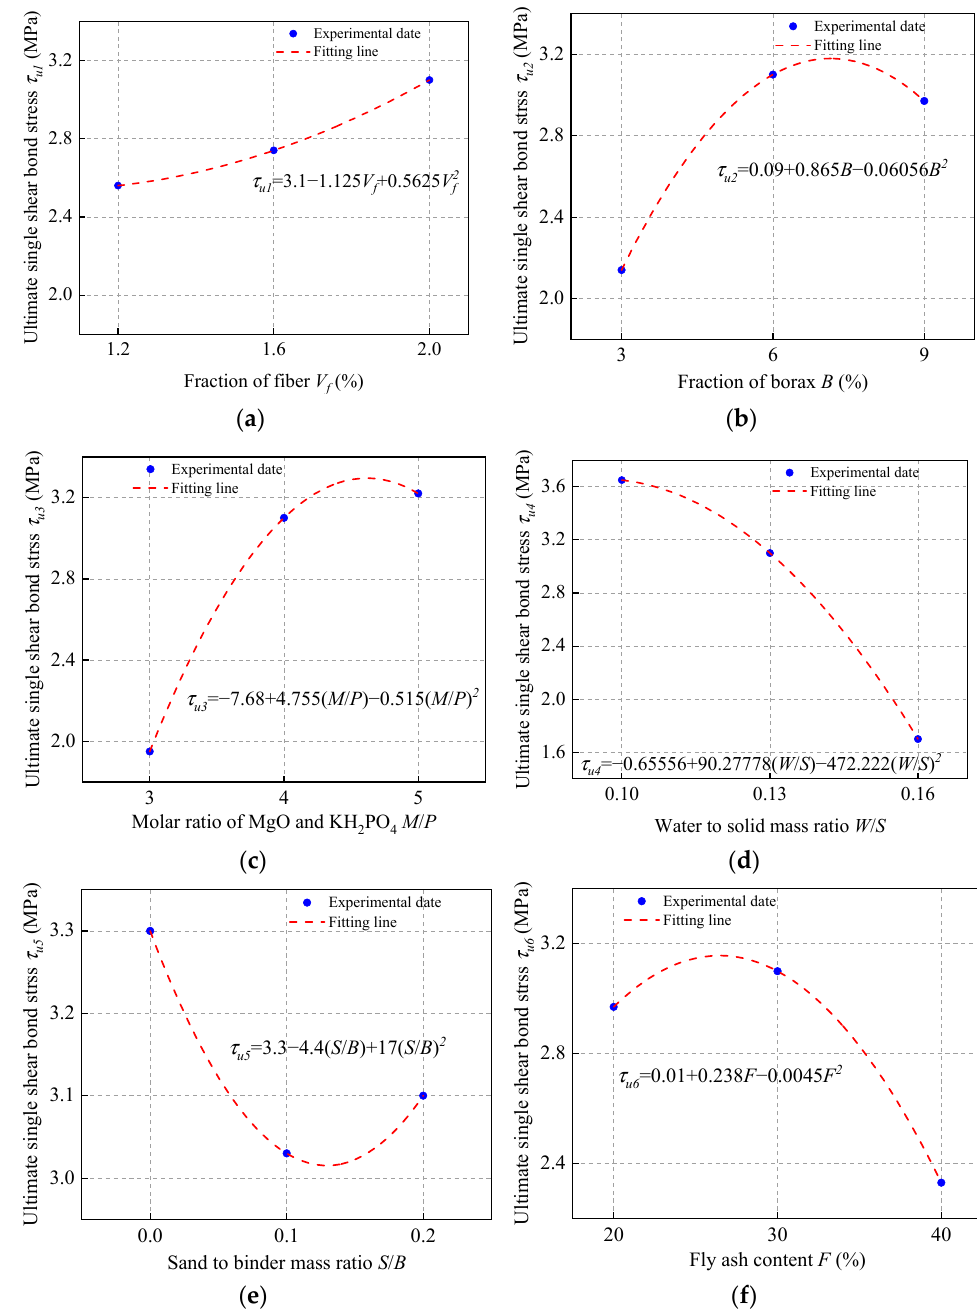
Figure 13. The fitting calculation of ( a ) τ u 1 ; ( b ) τ u 2 ; ( c ) τ u 3 ; ( d ) τ u 4 ; ( e ) τ u 5 ; ( f ) τ u 6 .